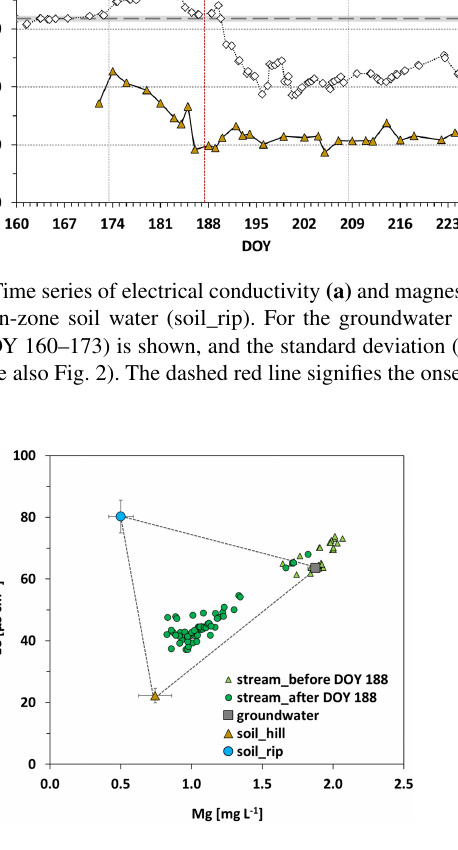
Figure 5. Mixing diagram showing streamflow tracer values for EC and Mg, separated in the period before and after DOY 188 (i.e., on- set of the main period), and end-member tracer signatures, including standard deviations (calculated for DOY 188–230).